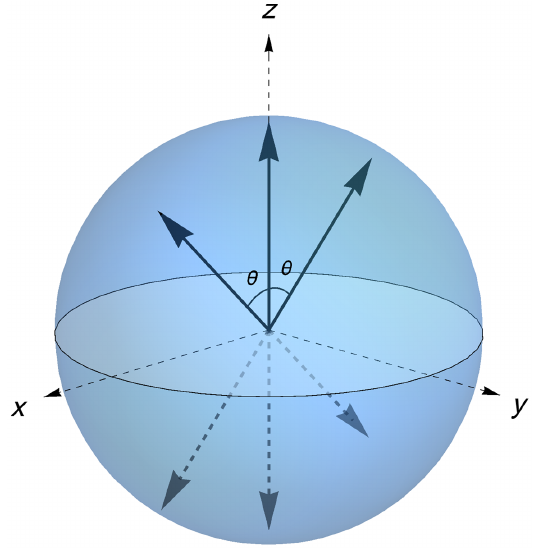
FIG. 6. Mirror-symmetric measurements used to show the existence of incompatible measurements that do not exhibit nonclassical statistics for any preparation set.